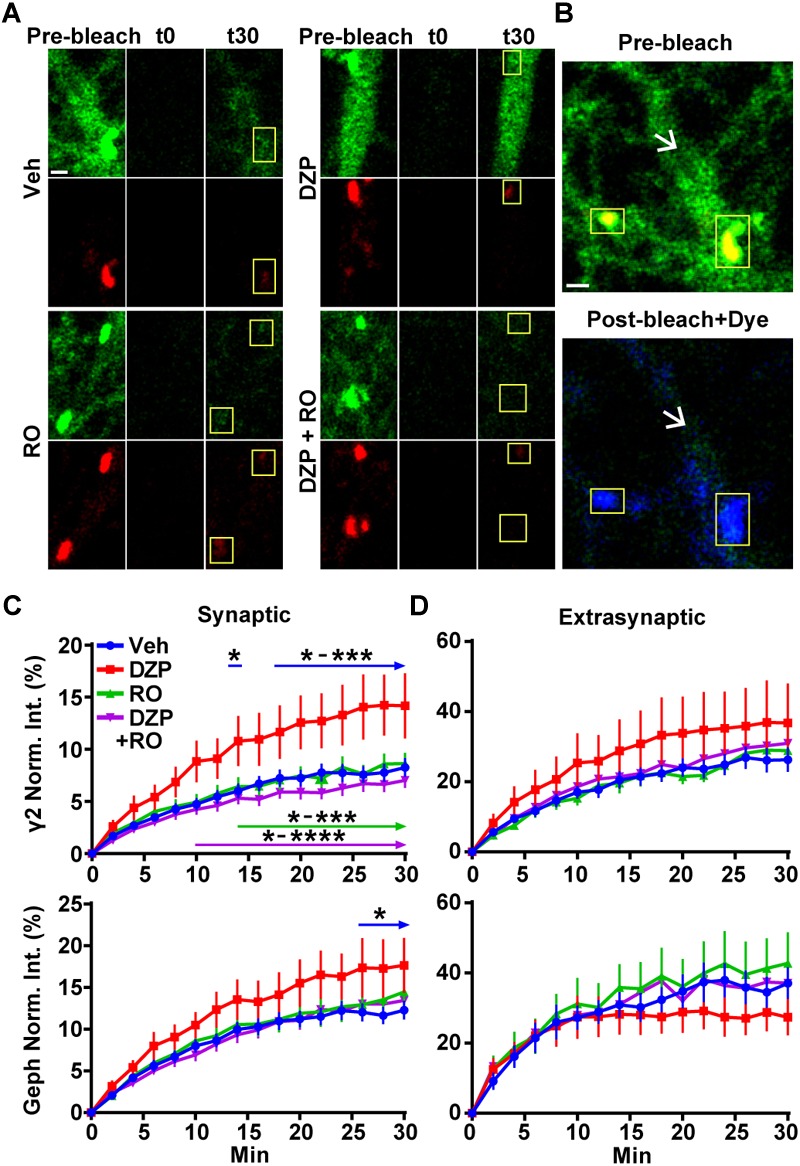
Prolonged DZP exposure accelerates γ2 GABAAR and gephyrin synaptic exchange. (A) Neurons expressing γ2pHFAP GABAAR (green) and RFP-gephyrin (red) were treated with vehicle or DZP for 20–28 h ± Ro 15-1788 for the last 1–2 h. Neurons were imaged at 37°C in constant presence of treatment. Initial image of dendrites taken prior to photobleaching (Pre-bleach), then imaged post-bleach (t0) every 2 min for 30 min. Images of dendritic regions show synaptic cluster sites (yellow boxes) and extrasynaptic regions. (B) 10 nM MG-BTau dye (blue) was added immediately after bleaching events in (A) to resolve bleached γ2pHFAP GABAARs and provide spatial accuracy for time series measurements. Panels show enlargement of vehicle dendritic regions identified in (A). Yellow boxes indicate synaptic clusters and arrows indicate extrasynaptic region seen by pHGFP fluorescence in pre-bleach (green) followed by post-bleach labeling with Mg-Btau (blue). (C,D) Fluorescence recovery of γ2 GABAAR and gephyrin measured at synaptic sites and extrasynaptic sites from (A). Synapse = γ2pHFAP cluster colocalized with gephyrin cluster. Int., fluorescence intensity. Image scale bars = 1 μm (∗p ≤ 0.05, ∗∗p < 0.01, ∗∗∗p < 0.001, ∗∗∗∗p < 0.0001, two-way ANOVA; Tukey’s multiple comparisons test; 4–8 synapses and one 10 μm extrasynaptic region per cell; n = 51–56 synapses from 16 neurons per treatment; 4 independent cultures; error bars ± s.e.m).